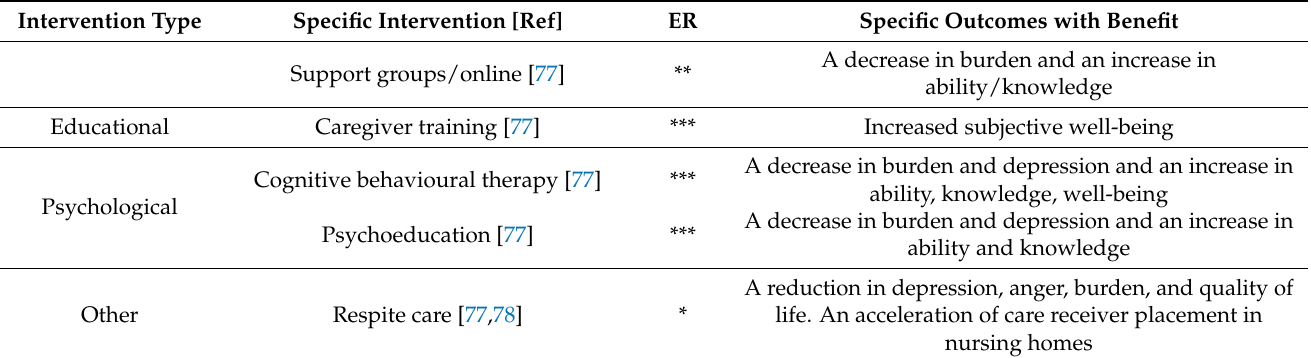
Table 9. Identified interventions for caregiver